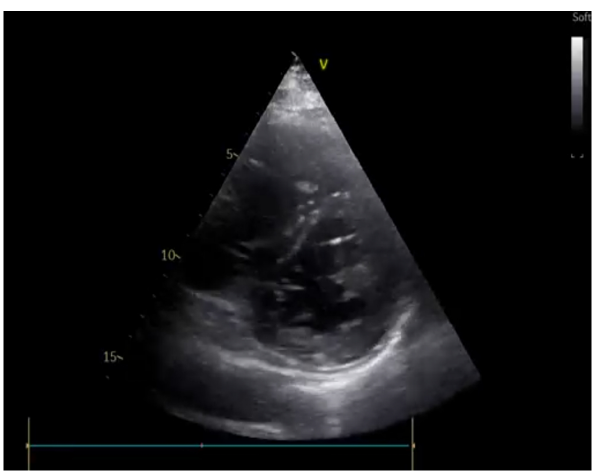
Figure 6. Systolic bowing of interventricular septum towards the left ventricle (D-shape) is associ- ated with pulmonary embolism and pulmonary hypertension. with pulmonary embolism and pulmonary (D) Diastolic function and Wedge pressure